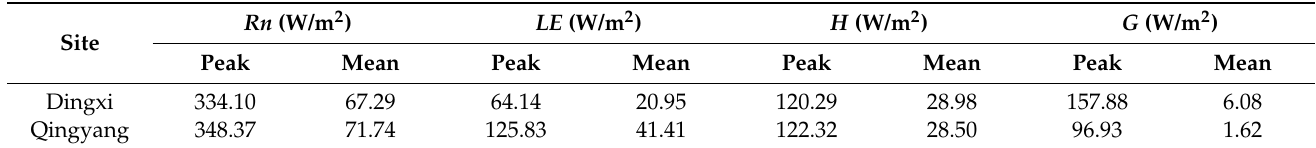
Table 3. Annual average daily peak values and average daily values of the energy